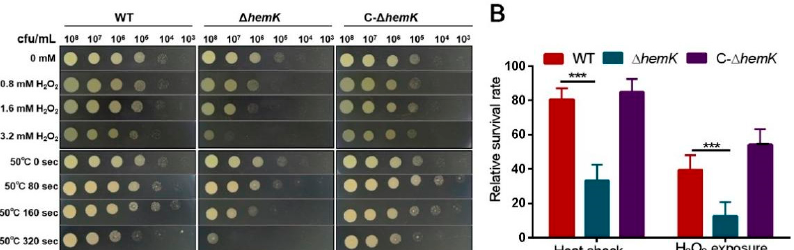
Figure 2. HemK contributes to stress tolerance. ( A ) The tolerance of wild-type Xcc jx-6 strain, ∆ hemK, and C- ∆ hemK was performed under H 2 O 2 -induced oxidative stress and heat shock. ( B ) Bacterial cell viability was estimated by measuring the value of OD 600 on the YEB medium before (T0) and after (T1) treatment. The survival rate was calculated as the ratio of the cell count at T1 to that at T0. Each test was repeated five times, and these five times had similar results. The data shown are the means and standard errors of five replicates. The significant difference between the WT and ∆ hemK with respective treatments: *** p < 0.001.